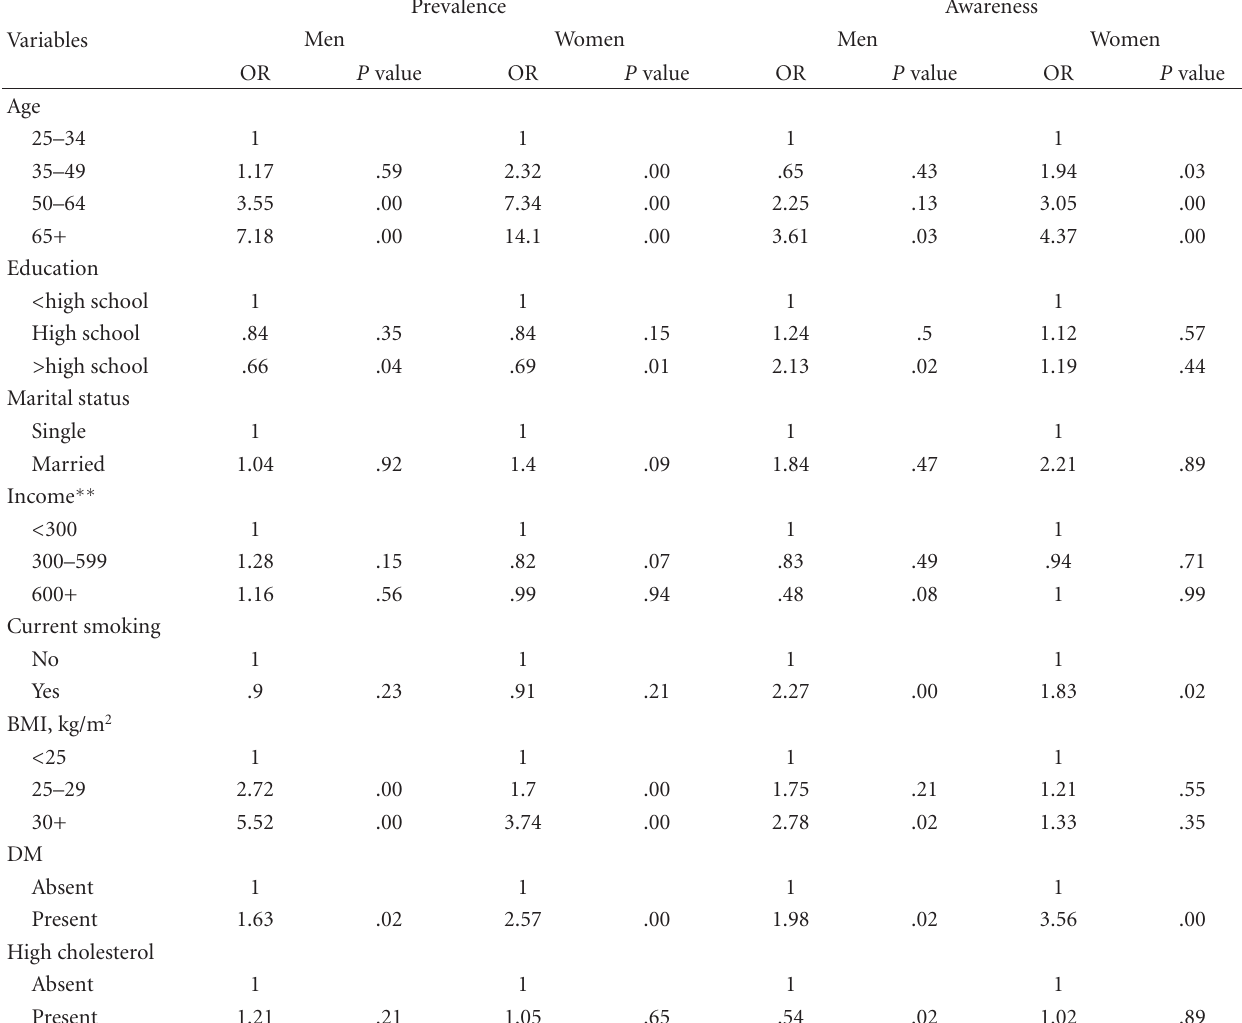
Table 2: Adjusted odds ratio (OR) and their P values of predictors of hypertension prevalence and awareness by sex. Prevalence